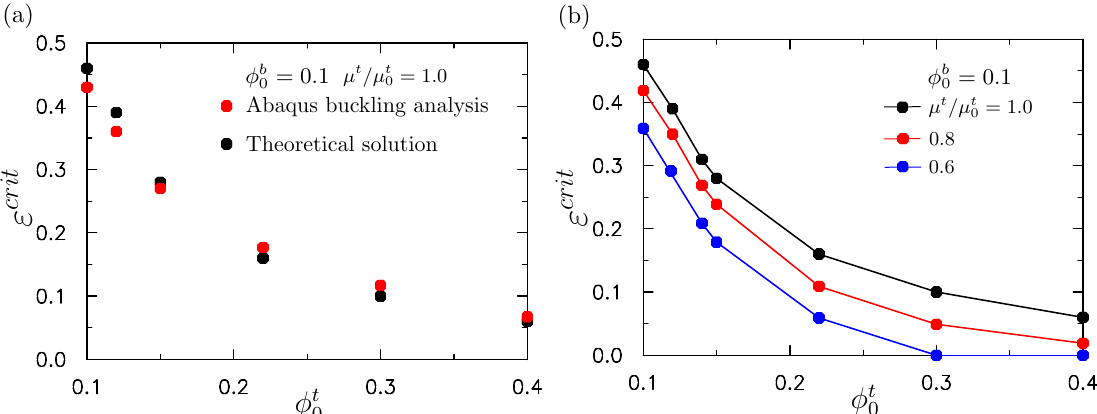
Figure 6. ( a ) Comparison of predictions for the critical strain at which the surface instability occurs for bilayer structure as a function of the initial volume fraction of polymer chain in the upper layer by the finite element (FE) simulation and theoretical analysis. There is no absorption of water in the upper = 1. ( b ) The critical compressive strain at which the surface instability occurred as a layer with µ t / µ t 0 function of the initial volume fraction of polymer chain in the upper layer under different levels of the = 1, 0.8, 0.6. The initial volume fraction of polymer chain of the lower pre-absorption of water: µ t / µ t 0 = layer was fixed as φ b 0